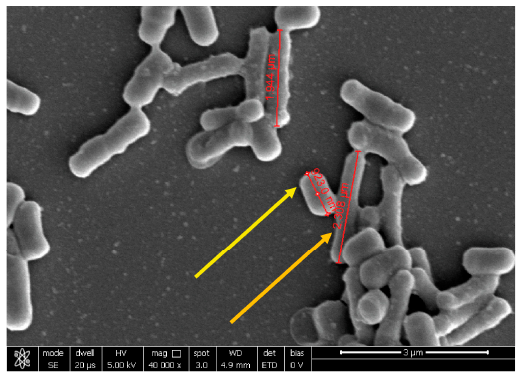
Figure 5. Representative image obtained with SEM of SynBalance ® Femme mixture and E. coli . The yellow arrow indicates the pathogen cell, while the orange arrow a probiotic bacterium. Magnification 40,000×.